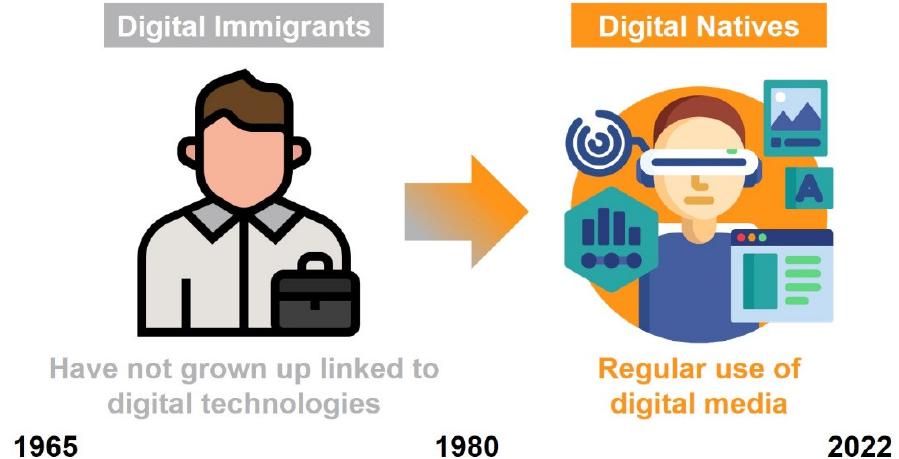
Figure 1. Main generations in terms of the degree of connection with digital technologies.